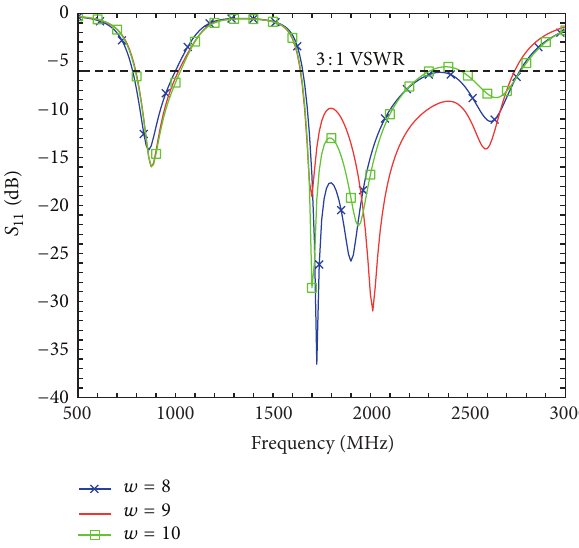
Figure 3: Simulated 𝑆 11 as a function of the top-width 𝑤 of the CPW-fed patch; other dimensions are the same as given in Figure 1 (unit: